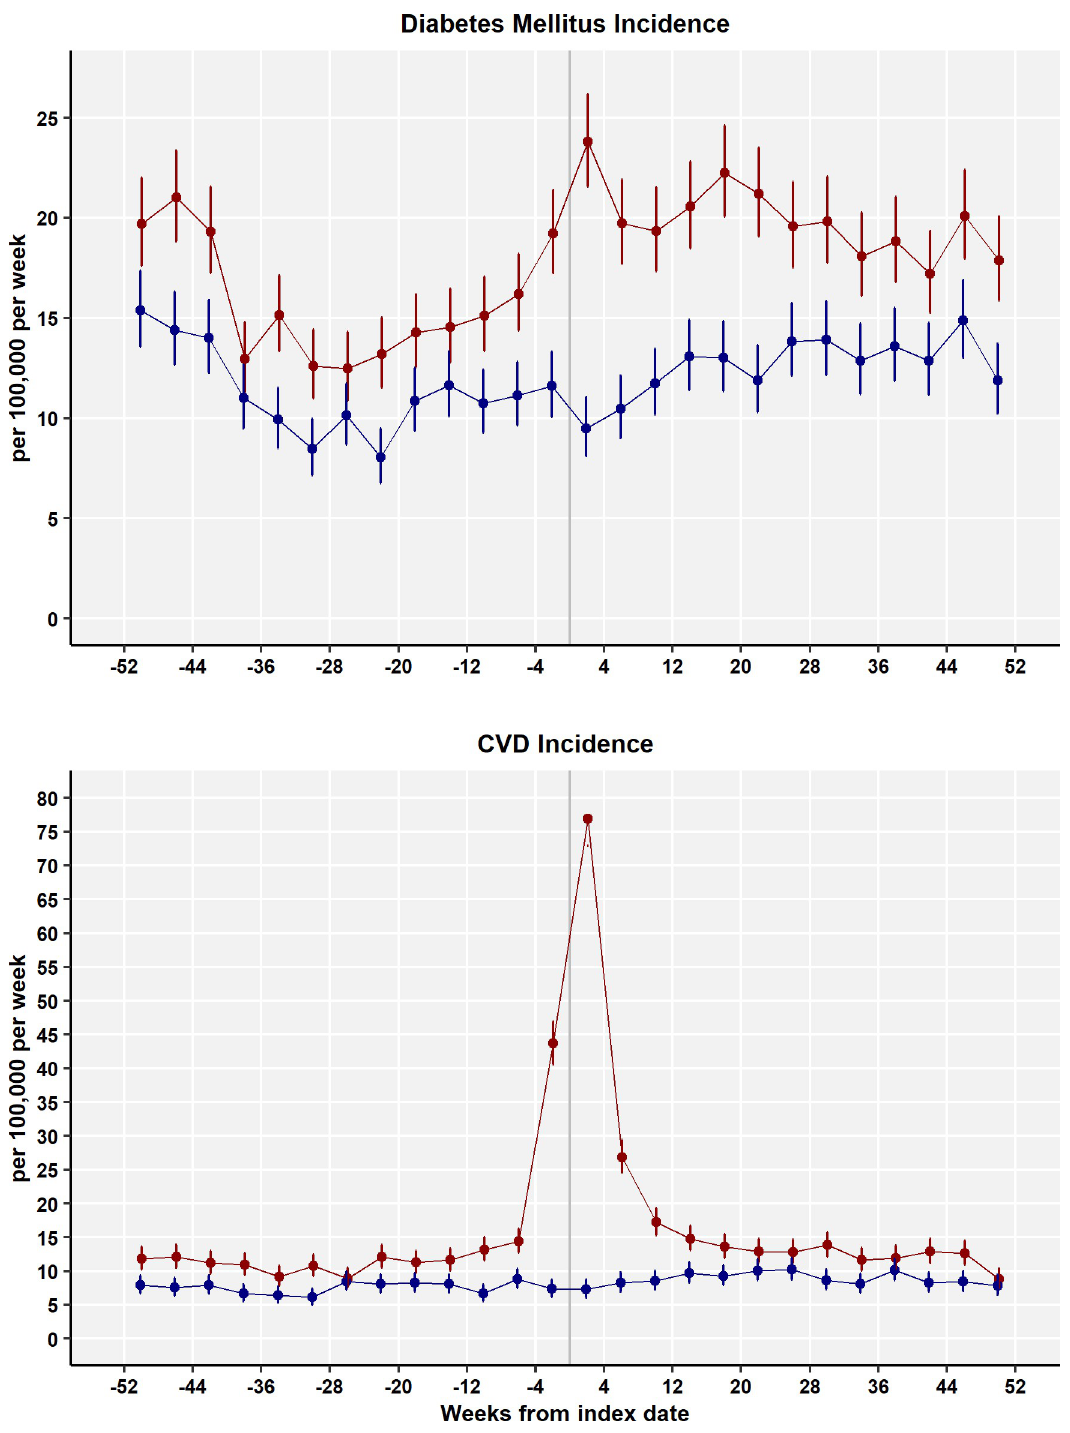
Fig 1. Incidence rates for DM and CVDs (per 100,000 patient weeks) for COVID-19 patients (red) and controls (blue) for 4-week periods. Bars are 95% CIs. AU : AbbreviationlisthavebeencompiledforthoseusedinFigs 1 (cid:0) 3 andTables 1 (cid:0) 3 : Pleaseverifythatallentriesarecorrect : CI, confidence interval; COVID-19, Coronavirus Disease 2019; CVD, cardiovascular disease; DM, diabetes